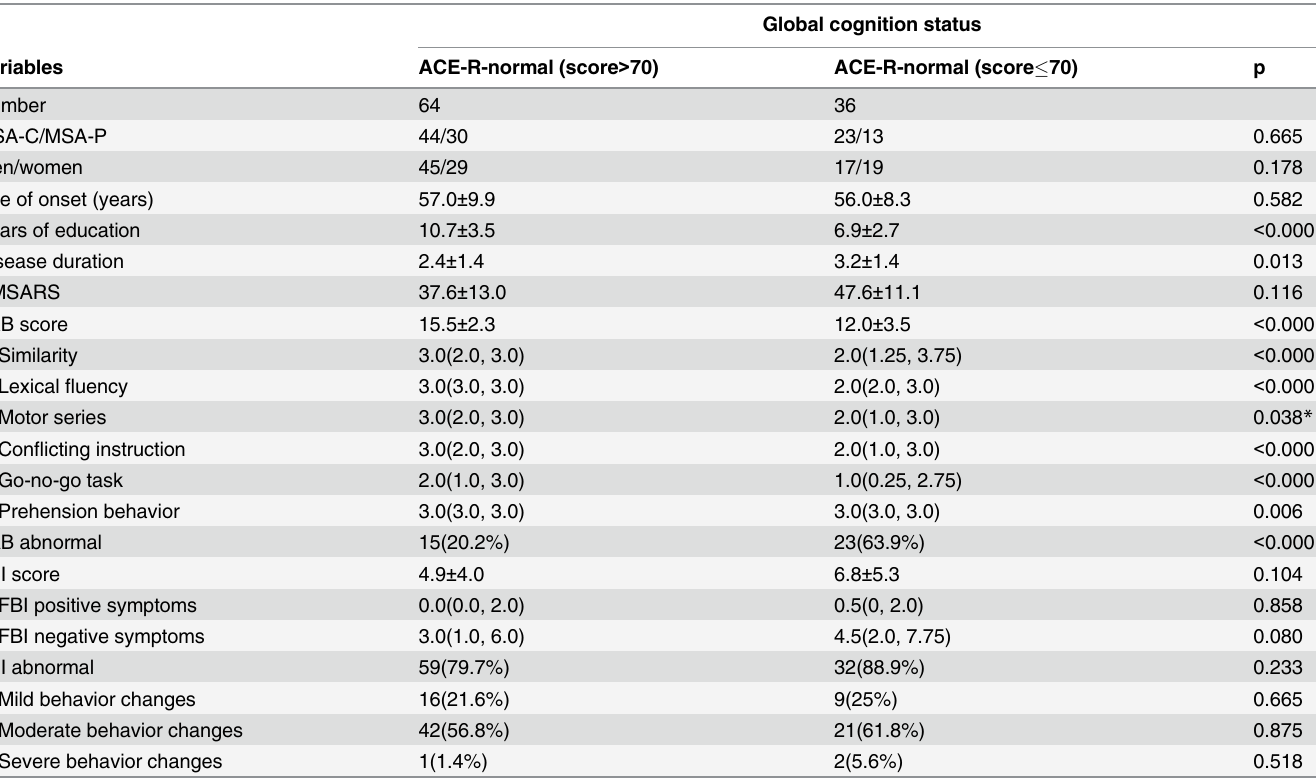
Table 2. Demographic and clinical characteristics of the MSA patients in terms of global cognition